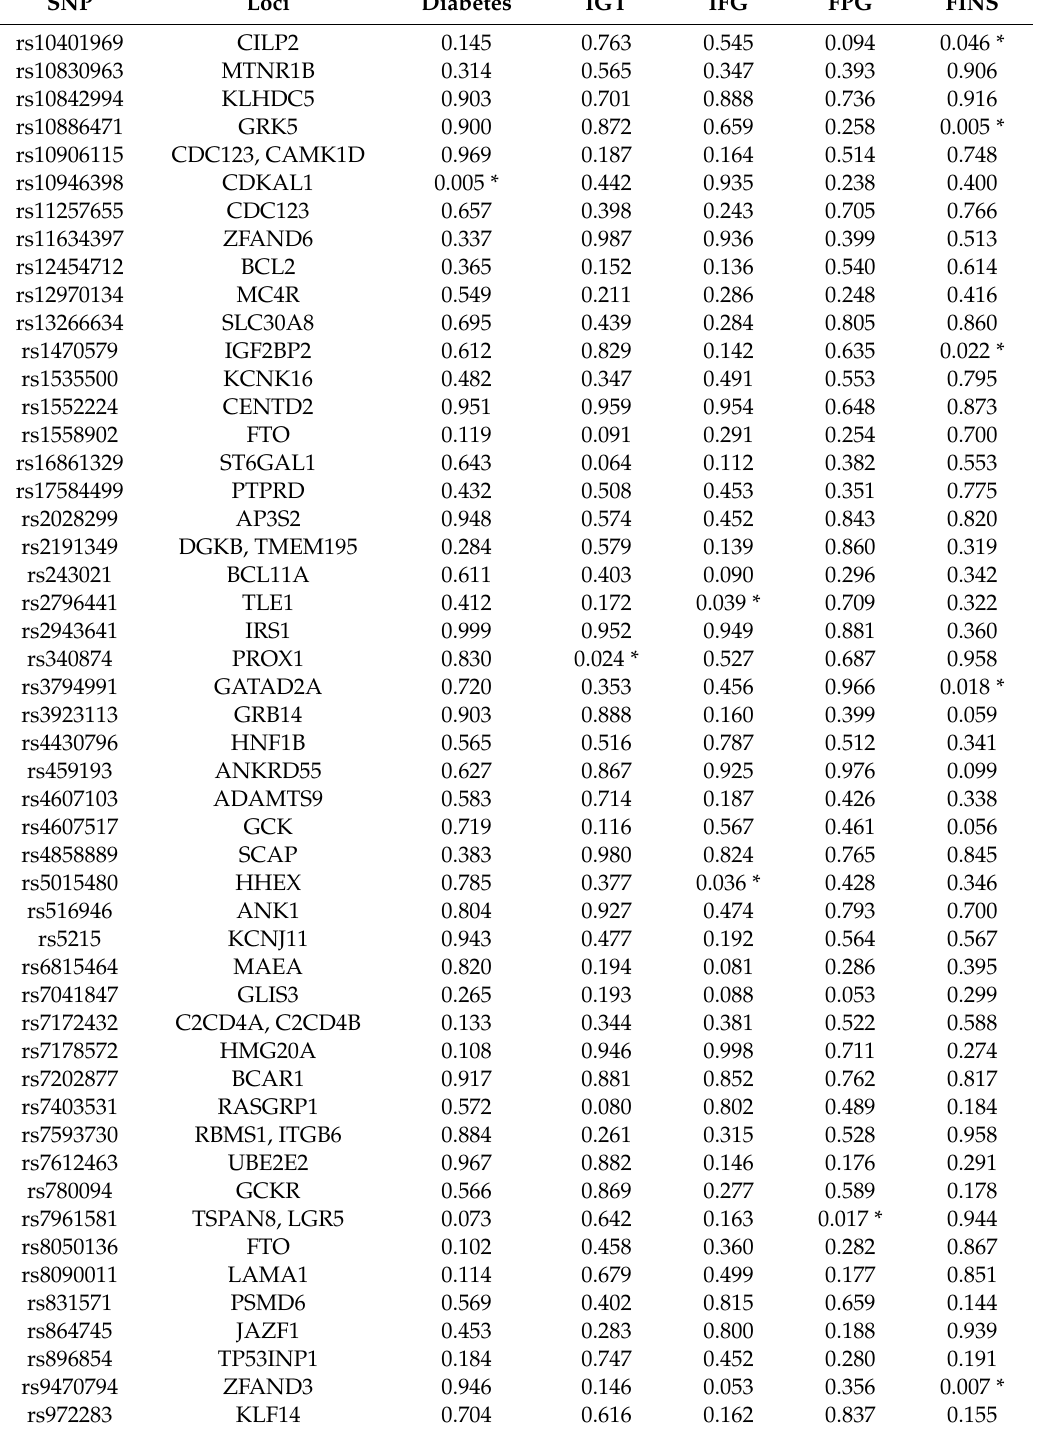
Table 2. Interactions of single-nucleotide polymorphisms (SNPs) with prenatal exposure to